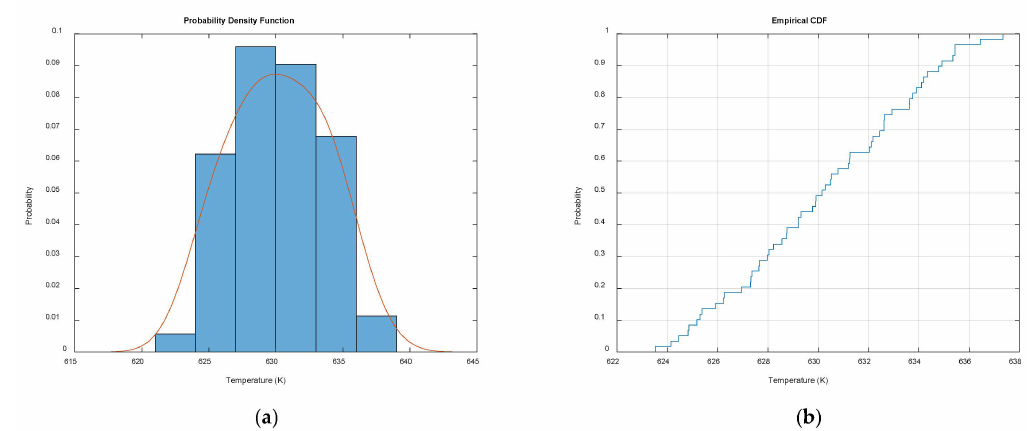
Figure 7. ( a ) PDF; ( b )